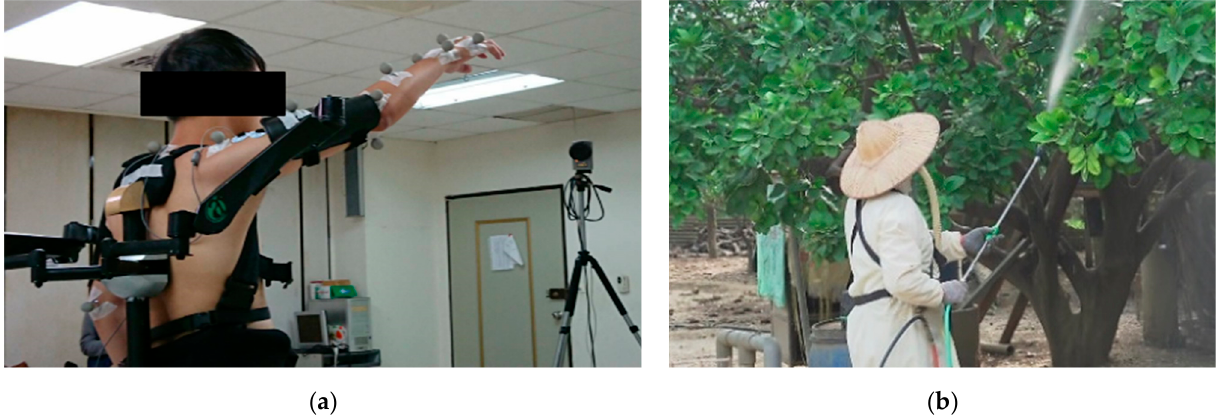
Figure 1. Experimental photographs. ( a ) Photograph of the passive upper-limb exoskeleton (PULE) during the simulation of fruit thinning; ( b ) Photograph of the pesticide spraying activity of the pomelo tree.